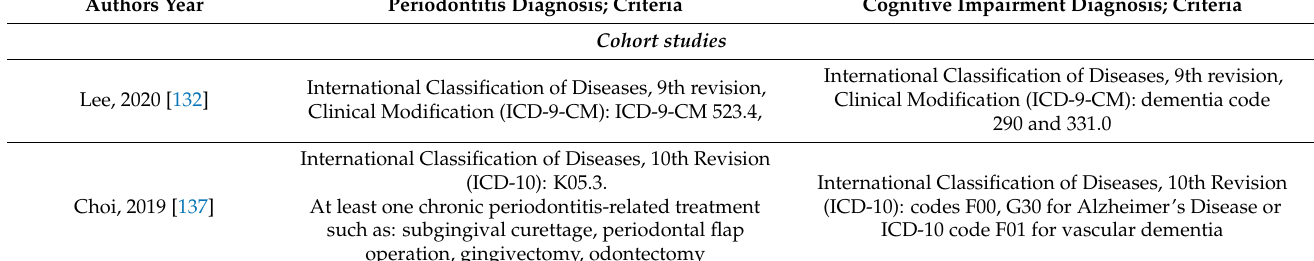
Table 3. Diagnostic criteria for periodontitis and cognitive impairment in 17 included